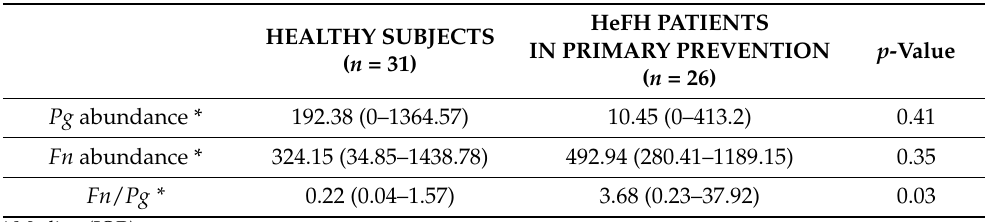
Table 7. Pg and Fn abundance: Comparison between healthy subjects and HeFH patients in primary